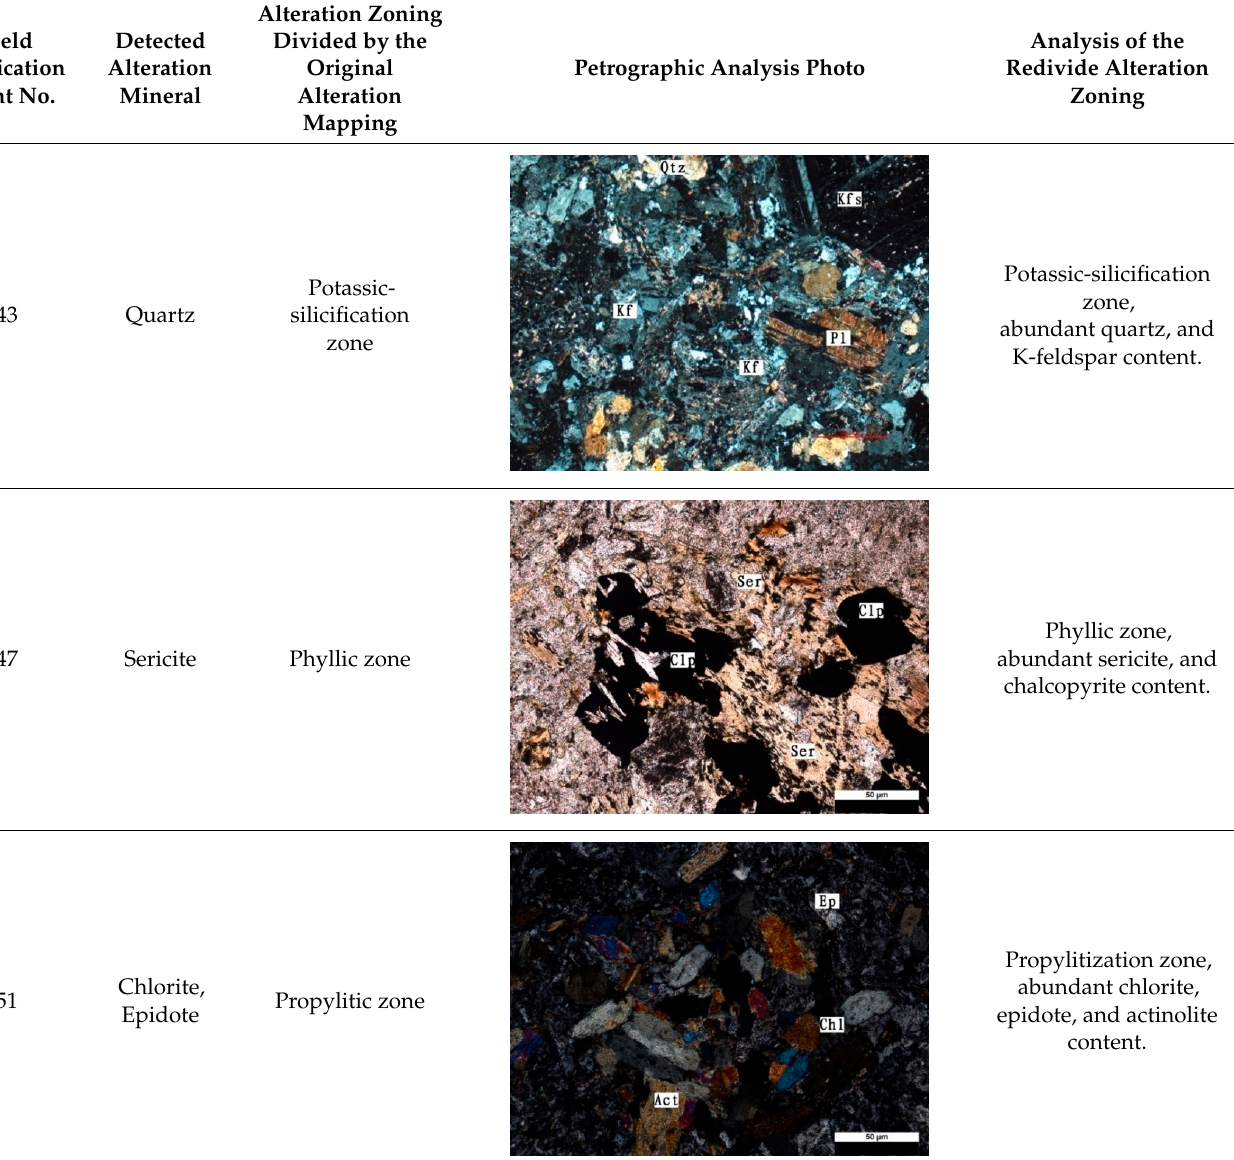
Table 6. Field verification survey for the redivided alteration zone.